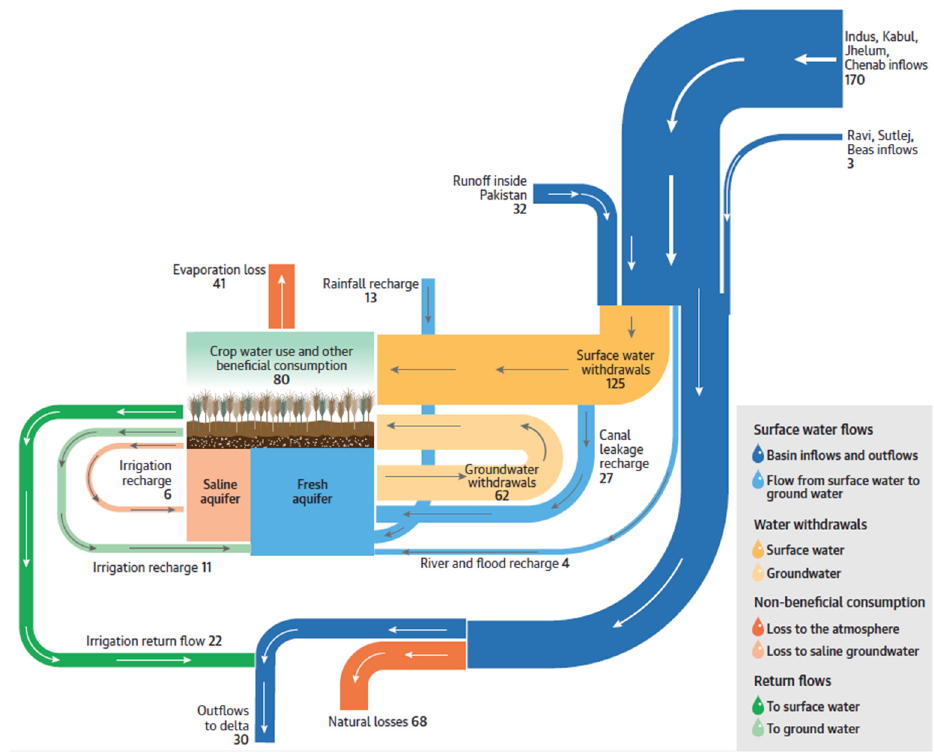
Figure 1. Average annual water balance of the Pakistan Indus Basin [9].